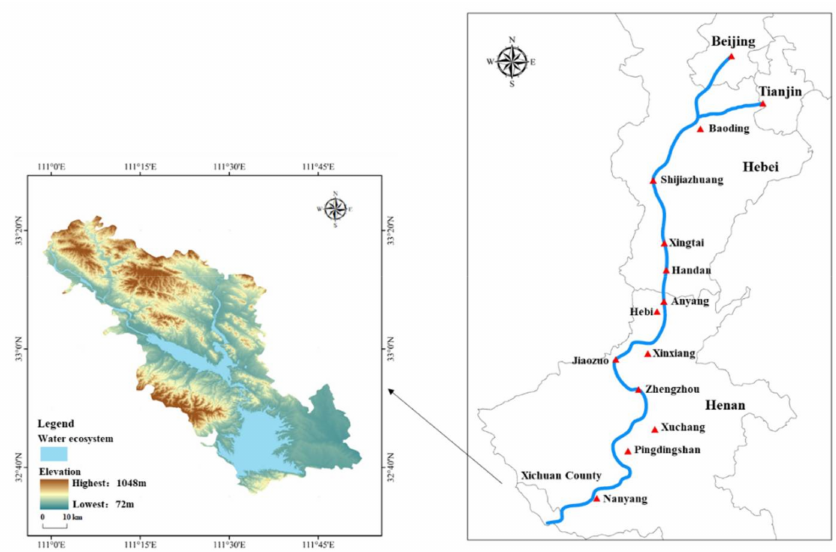
Figure 1. The central line project of SNWD and topographic map of Xichuan